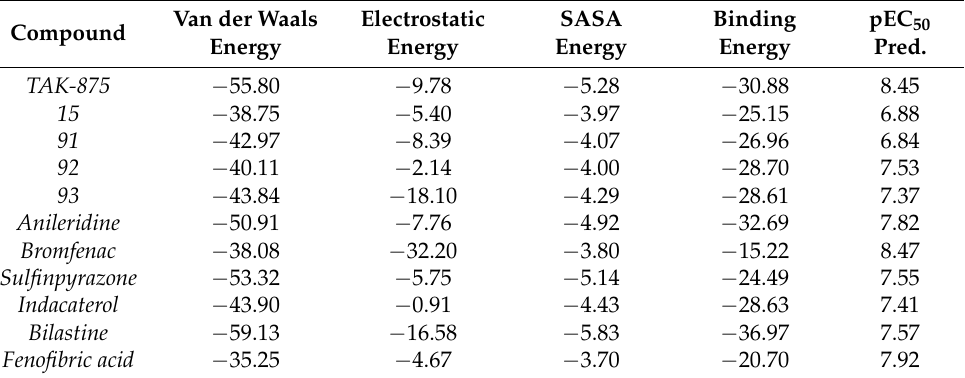
Table 4. Van der Waals, electrostatic, SASA, and binding energy (BE) (in kcal/mol) of the studied compounds. Van der Waals Electrostatic SASA Binding pEC 50 Compound Energy Energy Energy Energy